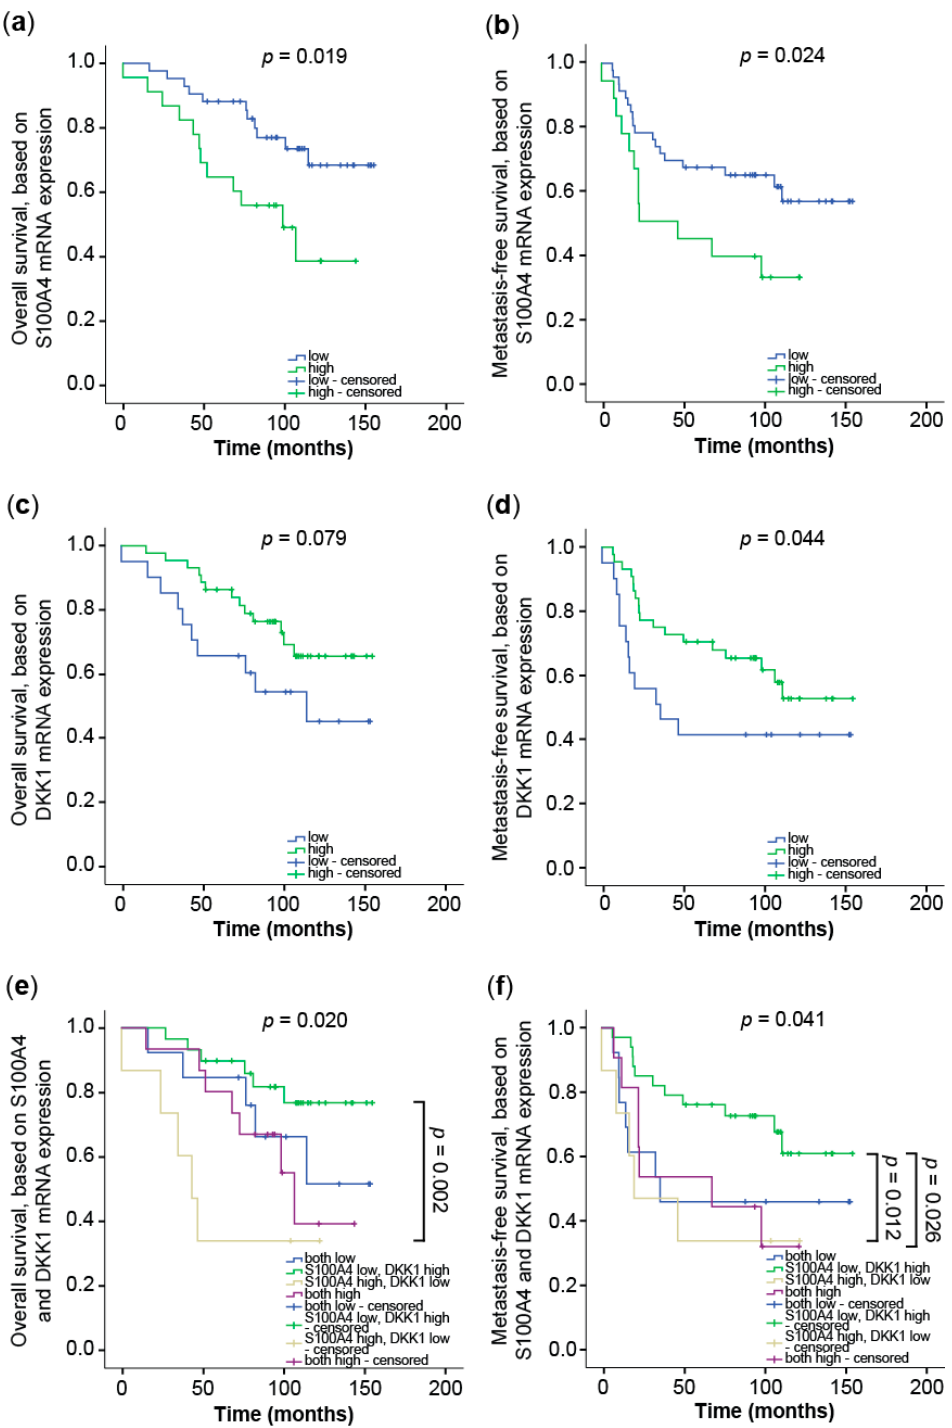
Figure 9. Combination of S100A4 and DKK1 for improved prognosis of OS and MFS of CRC patients. DKK1 and S100A4 mRNA expression levels were determined by qRT PCR in micro-dissected tumor cell populations of primary, not yet metastasized, tumors of stages I, II, and III ( n = 60). The cut-off values to distinguish low and high expression levels were determined by ROC analyses (highest Youden index: S100A4—2.68; DKK1—0.21). Survival analysis was performed with the Kaplan–Meier estimator, with a chi-square multiple comparison. OS ( a ) and MFS ( b ) of CRC patients, based on the S100A4 mRNA expression in the primary tumor. OS ( c ) and MFS ( d ) of CRC patients, based on the DKK1 mRNA expression in the primary tumor. OS ( e ) and MFS ( f ) of CRC patients, based on the combination of S100A4 and DKK1 expression in the